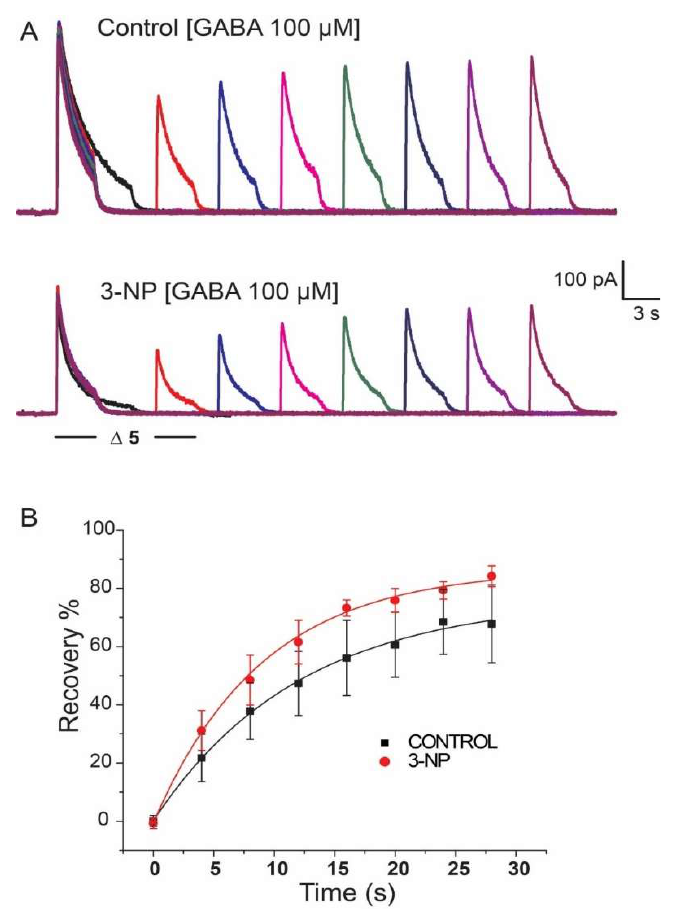
Figure 6. Recovery of I GABA . ( A ) Representative plot of the GABA (100 µ M) recovery protocol for a control group neuron and for a 3-NP group neuron. ( B ) Plot of the percentage of current recovery versus time for the application of 100 µ M GABA. Recovery time for the control group was similar for the recovery time for the 3-NP